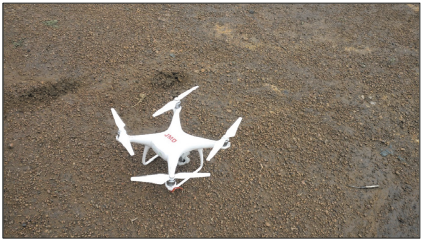
Figure 4: UAV data acquisition in the study area.